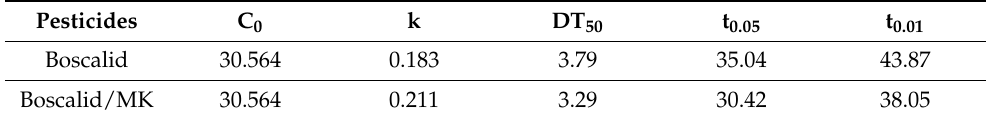
Table 6. Values of the coefficients of the equations of the dynamics of disappearance of boscalid with and without the addition of microorganisms (MK), half-life times of pesticides in DT 50 wastewater and theoretical times to reach concentrations of 0.05 and 0.01